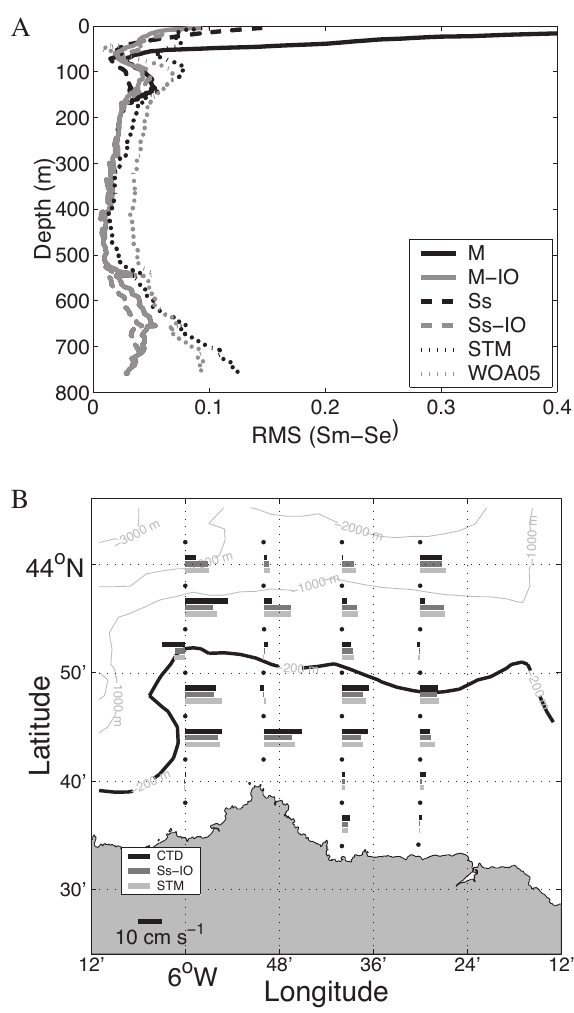
Fig . 11. – A, rms of the difference between measured and estimated salinity for six cases indicated in the legend (see text for details); B, surface geostrophic velocity during the GIJON-2006 exercise es- timated with the CTD data, with our best polynomial coefficients ( Ss − IO ) and with STM